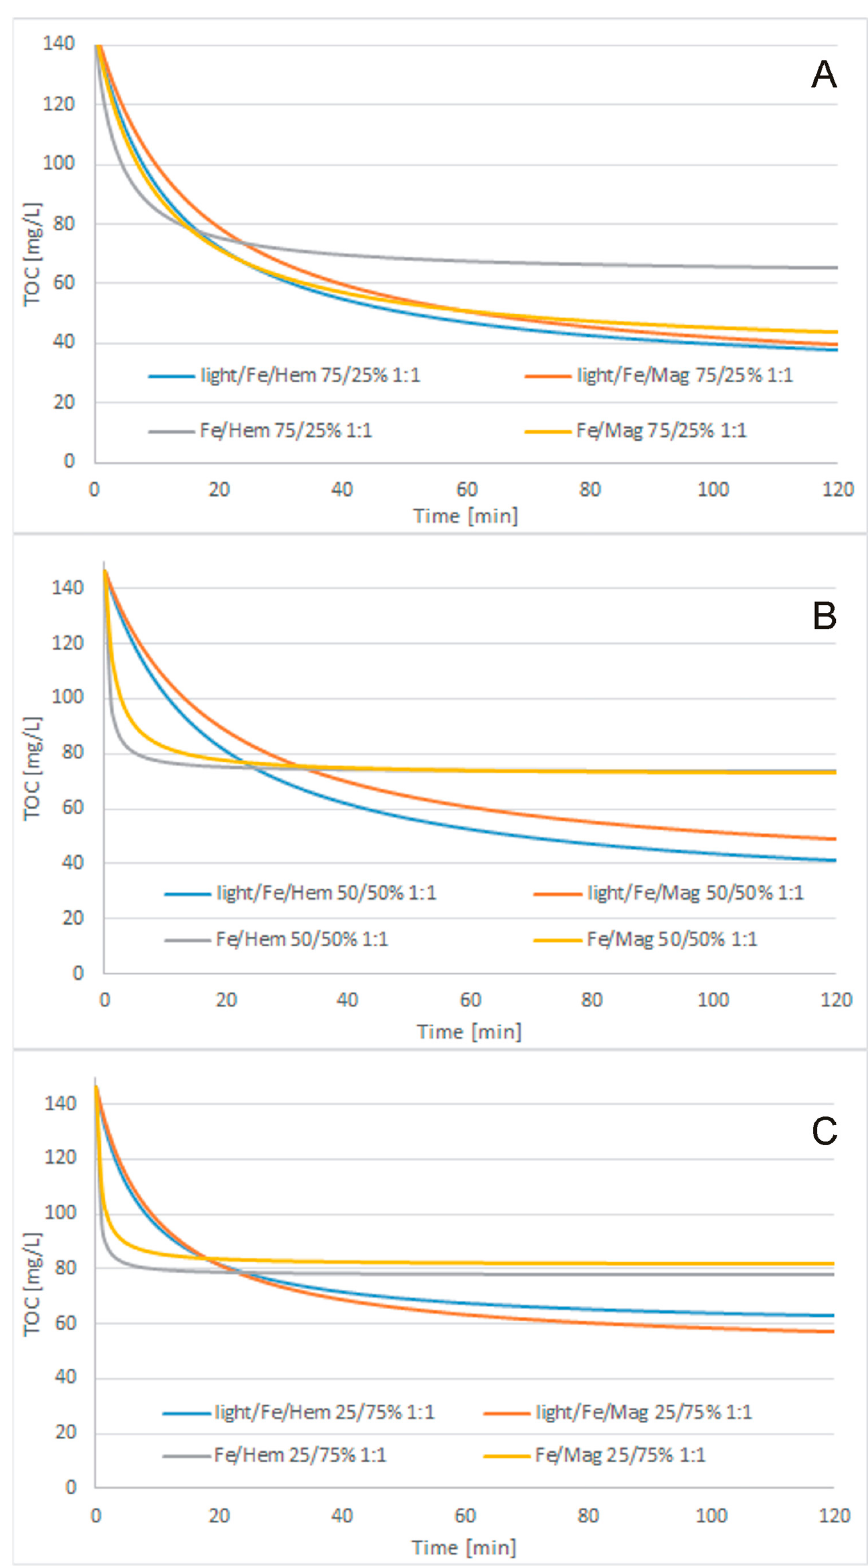
Figure 3. Cosmetic wastewater treatment, modified 2nd-order kinetic model matching results, 1:1 H 2 O 2 /COD ratio, catalyst ratio: ( A ) 75/25 Fe/Iron oxide, ( B ) 50/50 Fe/Iron oxide, ( C ) 25/75 Fe/Iron oxide.